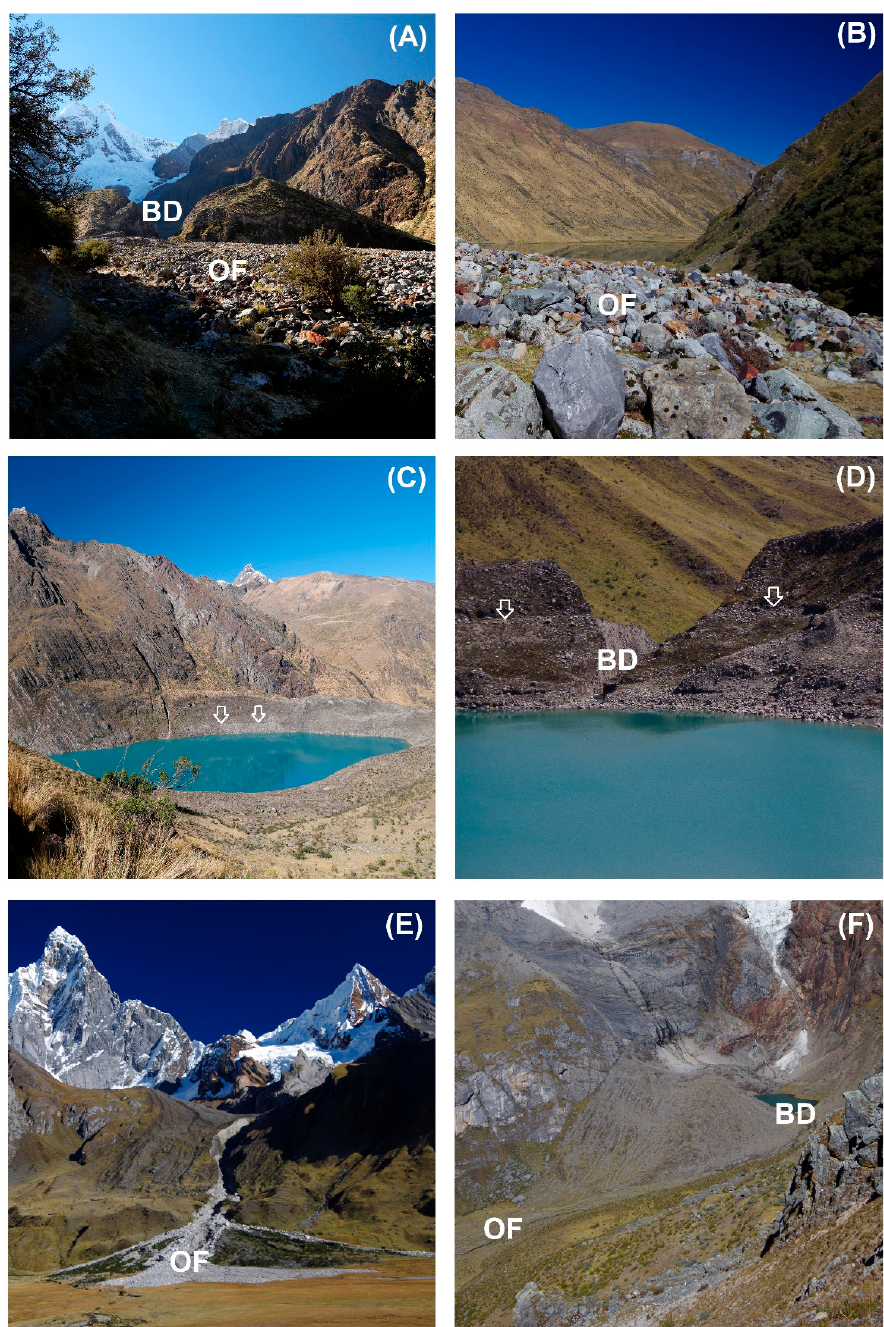
Figure 3. Examples of diagnostic features of past glacial lake outburst floods (GLOFs) in the Cordillera Huayhuash. ( A ) Upstream view on breached moraine dam (BD) of Lake Solteracocha (in centre background) with outwash fan located directly downstream from the dam (OF); ( B ) downstream view over this outwash fan (OF), the largest boulders are > 2 m in diameter; ( C ) visible evidence of Solteracocha pre-GLOF lake water level (arrows; GLOF in 1932); ( D ) downstream view through breached moraine dam (BD) of Lake Gangrajanca and pre-GLOF lake water level (arrows); ( E ) fresh outwash fan (OF) of recent ambiguous event associated with lake Chaclan; ( F ) breached moraine dam (BD) and partly vegetation-covered outwash fan (OF) of Unnamed lake (W032). All images were taken in 2018 and 2019 by